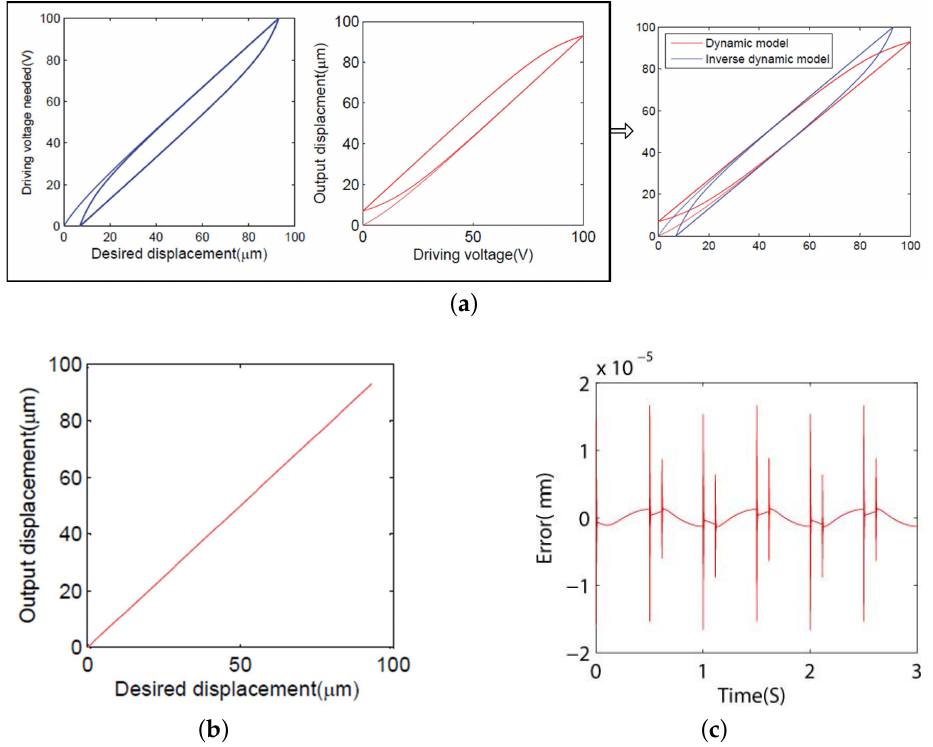
Figure 5. Simulation results with the inverse BW hysteresis compensator. ( a ) The hysteresis loop and inverse hysteresis loop.( b ) The relationship between the desired displacement and the output displacement. ( c ) The error between the desired displacement and the output displacement after hysteresis